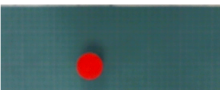
Figure 11. Acquired image of a red circle.